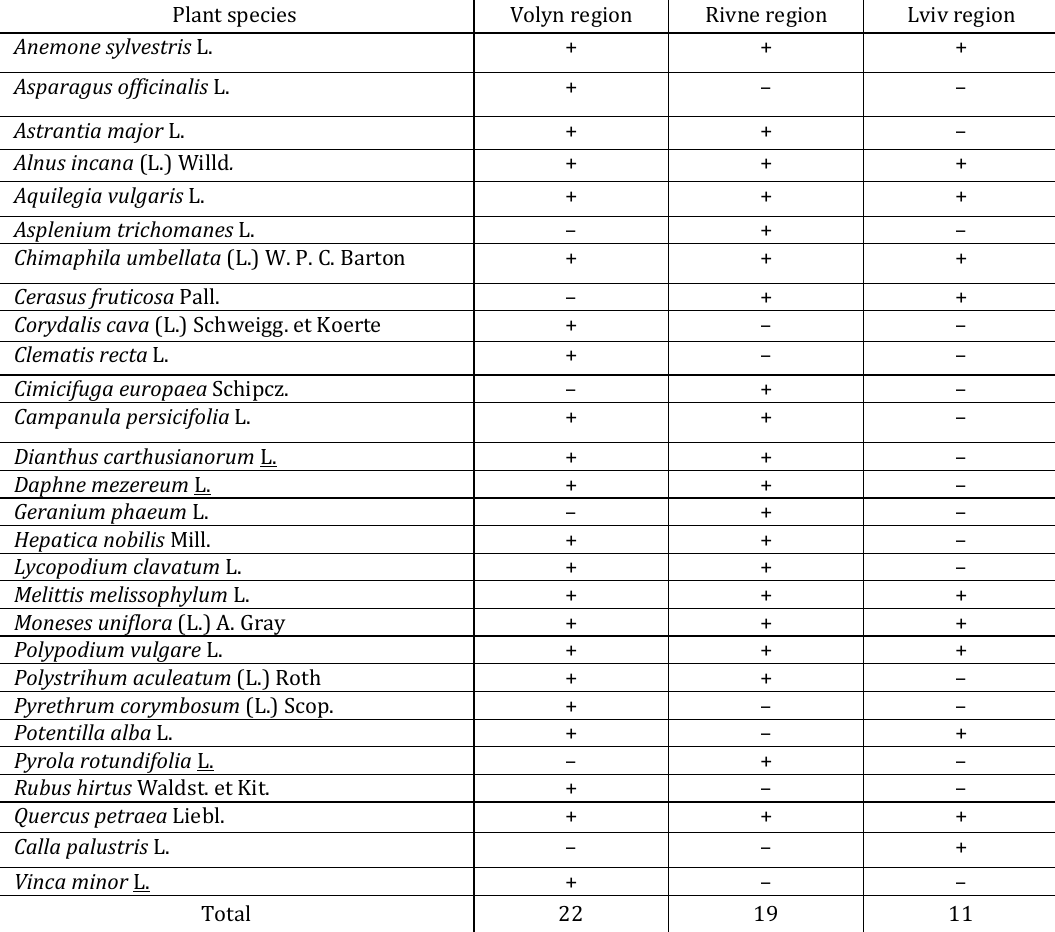
Table 2. Representation of regionally rare forest plant species of the Volyn Upland with an indication of administrative oblasts (regions) Plant species Volyn region Rivne region Lviv